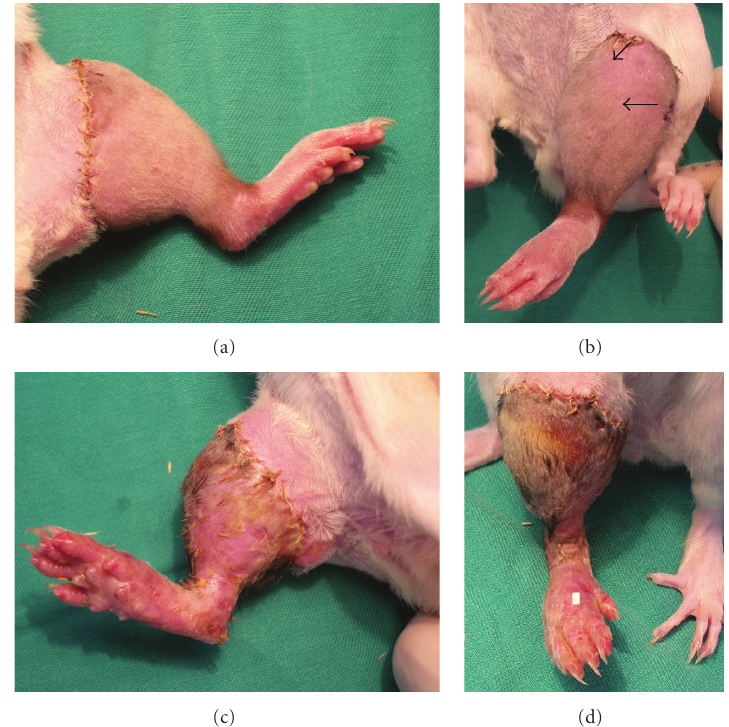
Figure 2: TREATED/VCA (panels (a) and (b)) and SHAM/VCA ((c) and (d)) on post-transplant Day +10. Arrows highlight the commencement of shedding of VCA hair in a TREATED/VCA rat. In contrast, recipients in the SHAM/VCA group ((c) and (d)) had commenced rejection at least three days previously and by now rejection was